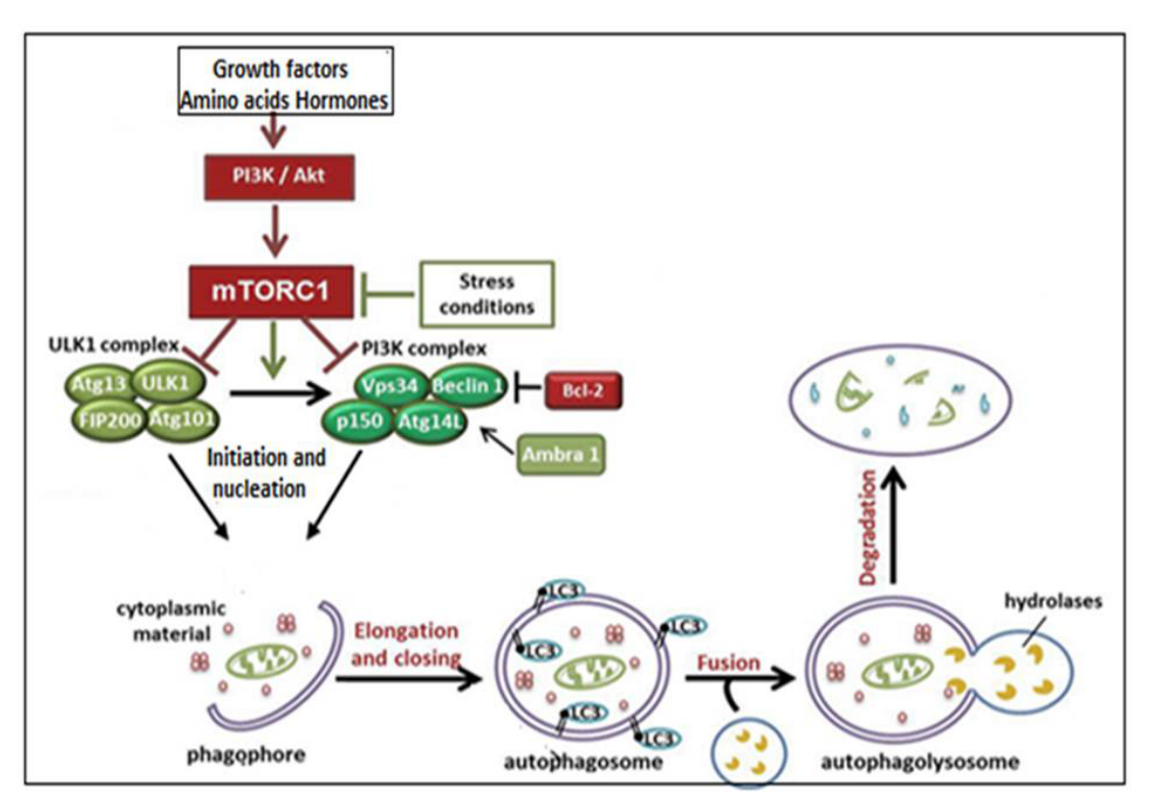
Figure 1: Schematic representation of signaling pathways involved in autophagy multistep regulation. In presence of growth factors and hormones, mTORC1 inhibits autophagy activation (Vomero M, Barbati C, Colasanti T, Perricone, C Novelli L, Ceccarelli F et al . Autophagy and Rheumatoid Arthritis: Current